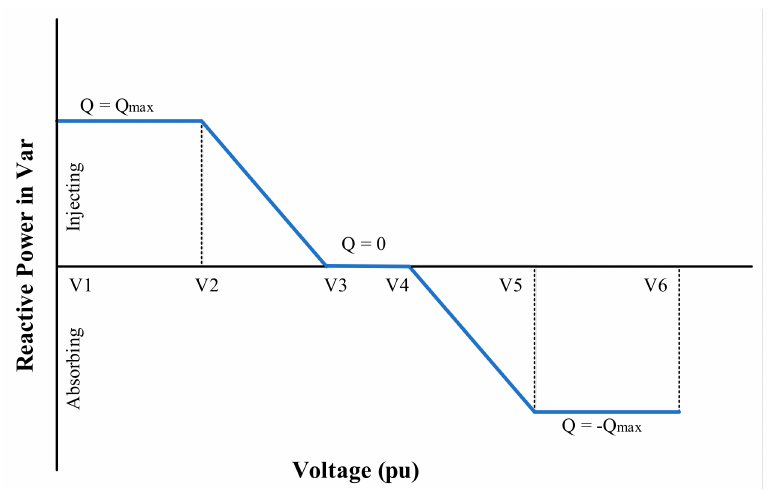
Figure 4. A generic Volt-Var